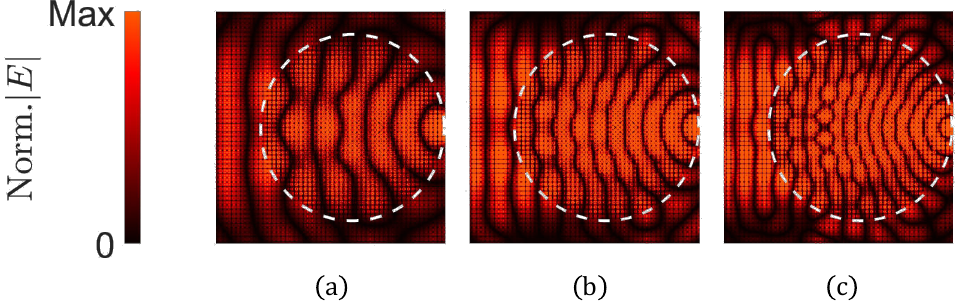
Figure 6. Full-wave simulated absolute value of E -field in the meta-lens whose background is filled with the same unit cell as in the lens exterior at: ( a ) 12GHz; ( b ) 18GHz; ( c ) 24GHz. The lens circumference is outlined by a dashed